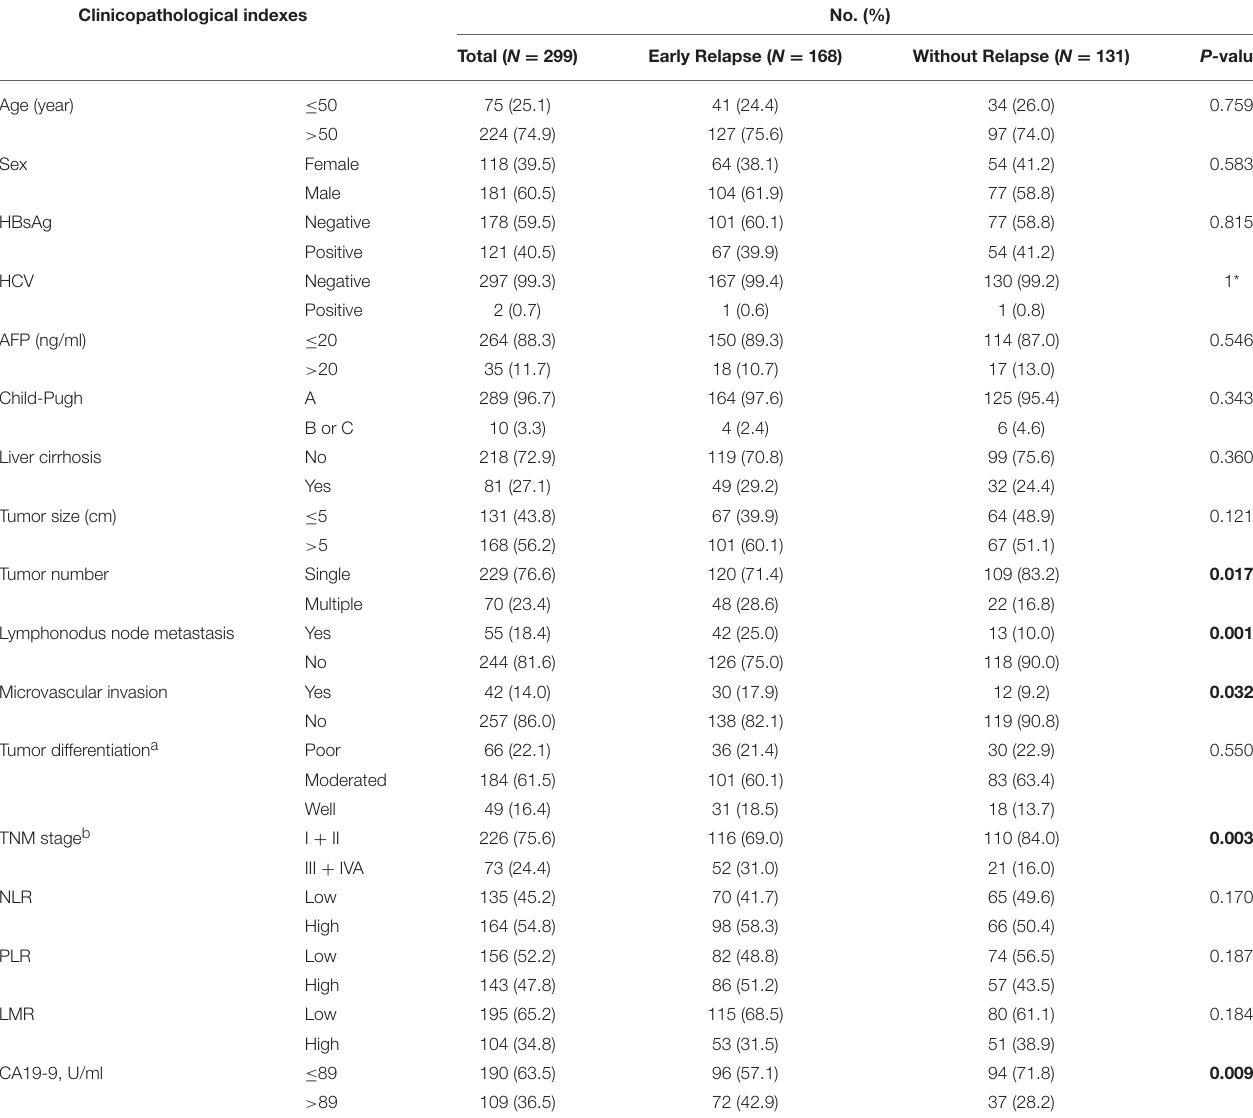
TABLE 1 | Clinical and pathological characteristics of patients with early and without relapse after curative liver resection for intrahepatic cholangiocarcinoma ( n = 299). Clinicopathological